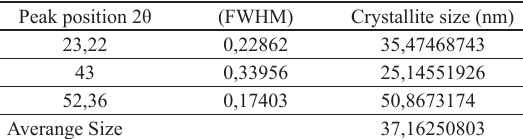
Table 2. Average CdTe/FTO cristalits size by